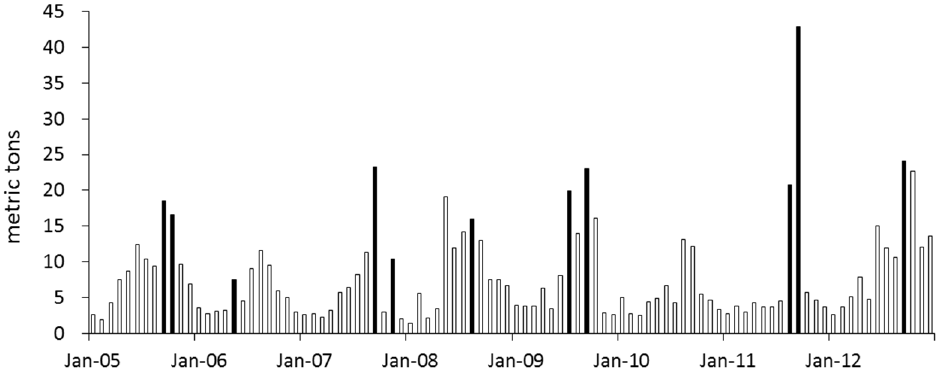
Figure 10. Monthly Chl- a mass in Taihu from 2005 to 2012, based on data from 32 sampling sites. Black columns represent Chl- a mass in the next month after tropical cyclones passed.